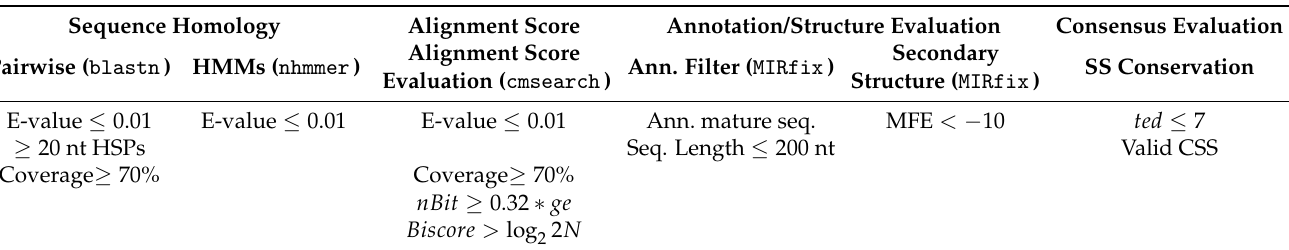
Table 4. Homology, structure and final filters applied on miRNAture . Specific programs used for each mode in parenthesis. Ann. : Annotation, SS : Secondary structure. CSS : Consensus secondary structure. ge : gathering cutoff from Rfam family. nBit = Bitscore / ge . ted : tree edit distance between default miRNA and modified multiple stockholm alignments. MFE : Minimum free energy. HSPs : high scoring